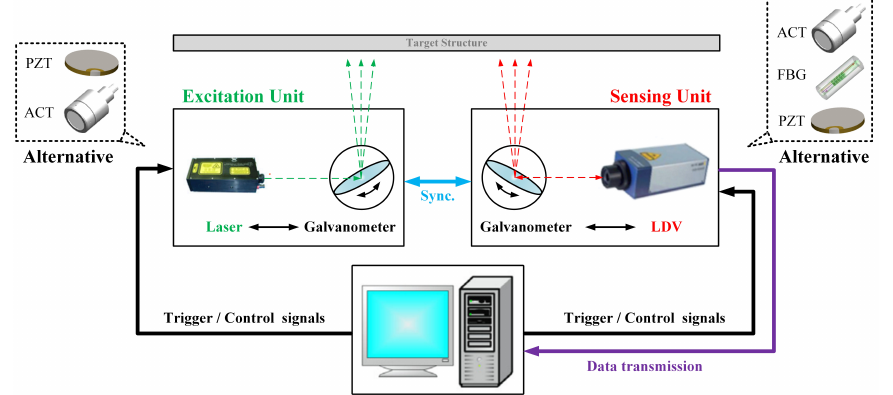
Figure 4. Setup of the laser ultrasonic Lamb wave detection